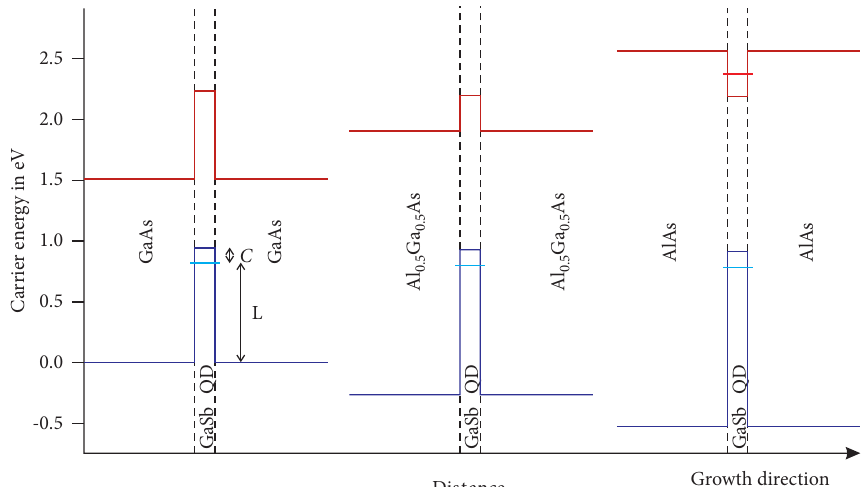
Growth direction Distance